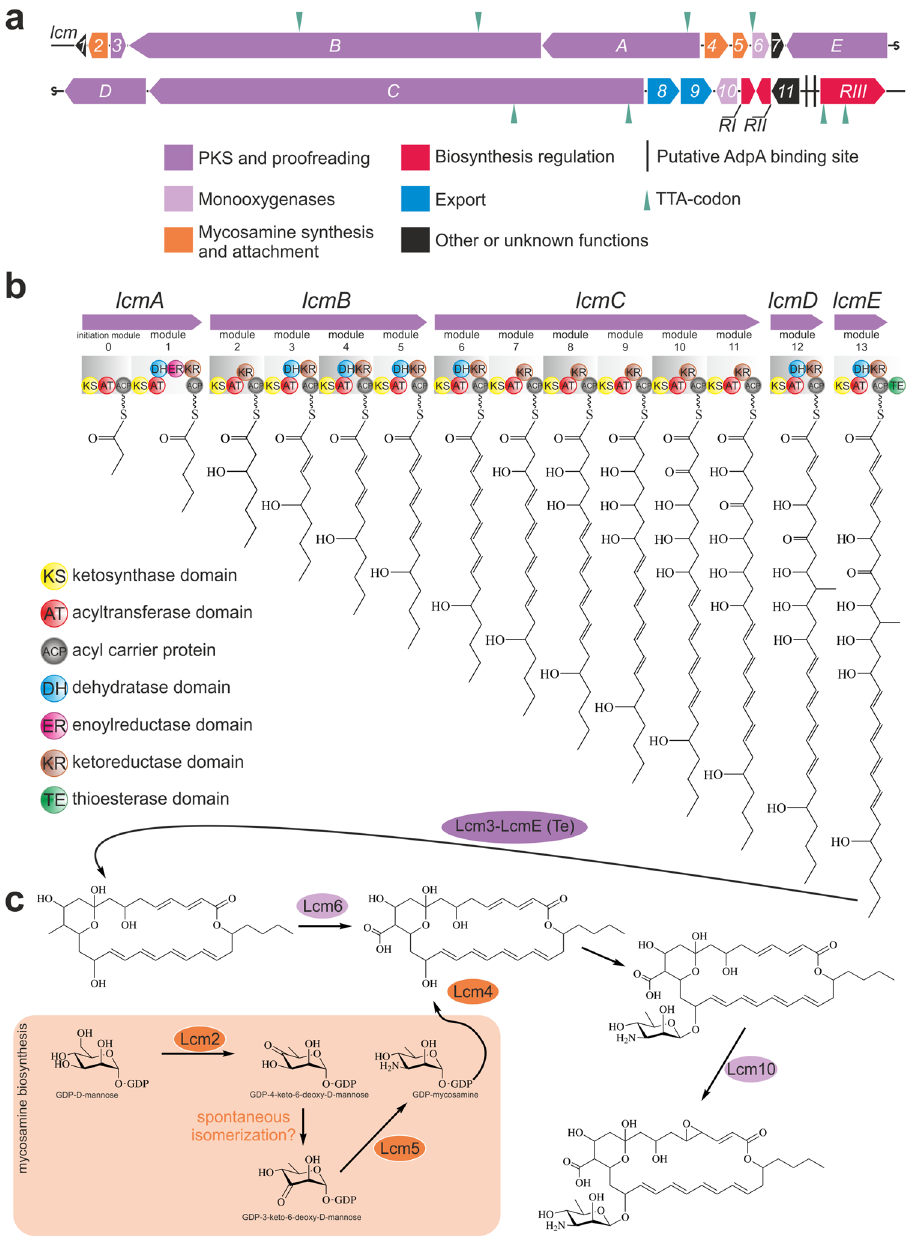
Figure 3. A scheme of Lcm biosynthetic gene cluster ( lcm BGC) ( a ) and proposed sequence for the Lcm PKS assembly line ( b ) with the tailoring reactions ( c ). For more details, please see the main text and Table